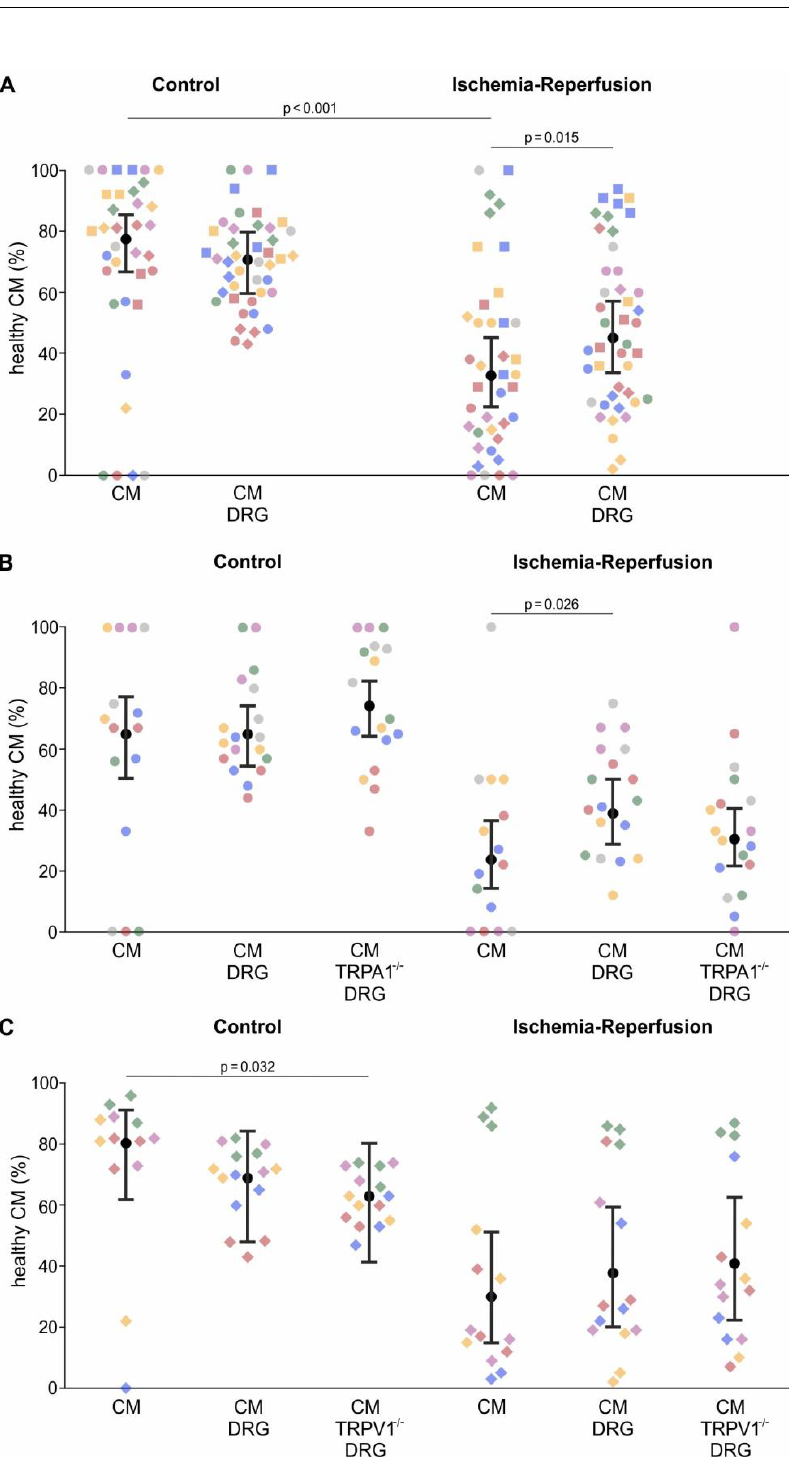
Figure A4. Sensory neurons increased the survival of CM in ischemia-reperfusion. Percentage of healthy CM at the end of the cellular model for IR within each well. Every colour–shape combination represents one experiment. The black dots represent the estimated survival probabilities ± 95% CI. ( A ) IR conditions led to a significant reduction in CM survival. ( B ) Compared to CM alone, the addition of wildtype but not TRPA1 − / − sensory increased the survival of cardiomyocytes. ( C ) In control conditions, the addition of TRPV1 − / − sensory neurons led to a significant decrease in survival probability of CM. In IR, the addition of TRPV1 − / − sensory neurons did not change the survival of cardiomyocytes compared to cardiomyocytes alone ( p = 0.18). The median number of counted cells in each well was 67 (range 2–2975). Overall, 65255 cells were